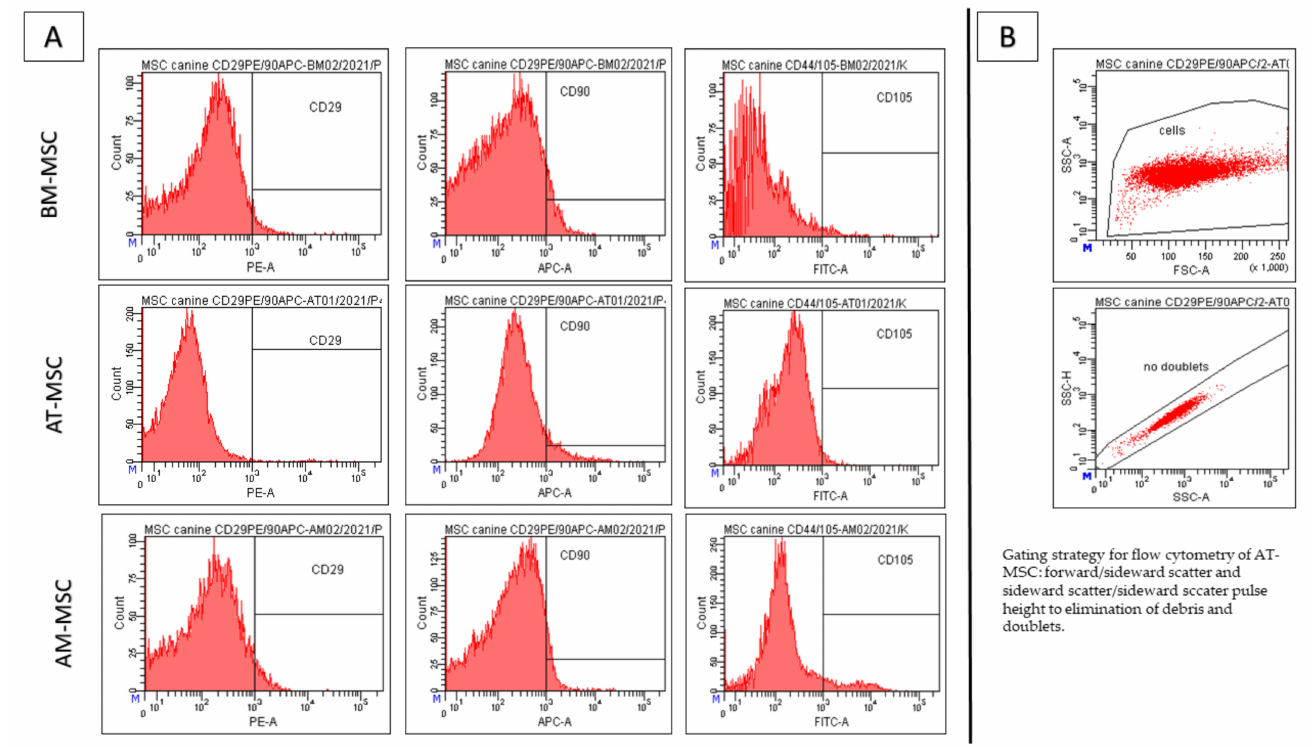
Figure 4. Results of the CD analyses from passage 3 (P3)—negative control ( A ) and Gating strategy ( B ). The BM-MSCs showed minimal autofluorescent positivity for PE (1.1% ± 0.1%), FITC (1.2% ± 0.05%) and APC (2.5% ± 0.5%). The AT-MSCs showed a high number of autofluorescent cells for APC (4.0% ± 0.2%) and a minimum of PE-autofluorescent cells (0.3% ± 0.0 5%) and FITC (0.6% ± 0.01%). We observed the highest number of autofluorescent cells in AM-MSCs: PE (1.8% ± 0.3%), APC (4.5% ± 0.9%) and FITC (2.9% ± 0.5%). Gating strategy—forward/sideward scatter and